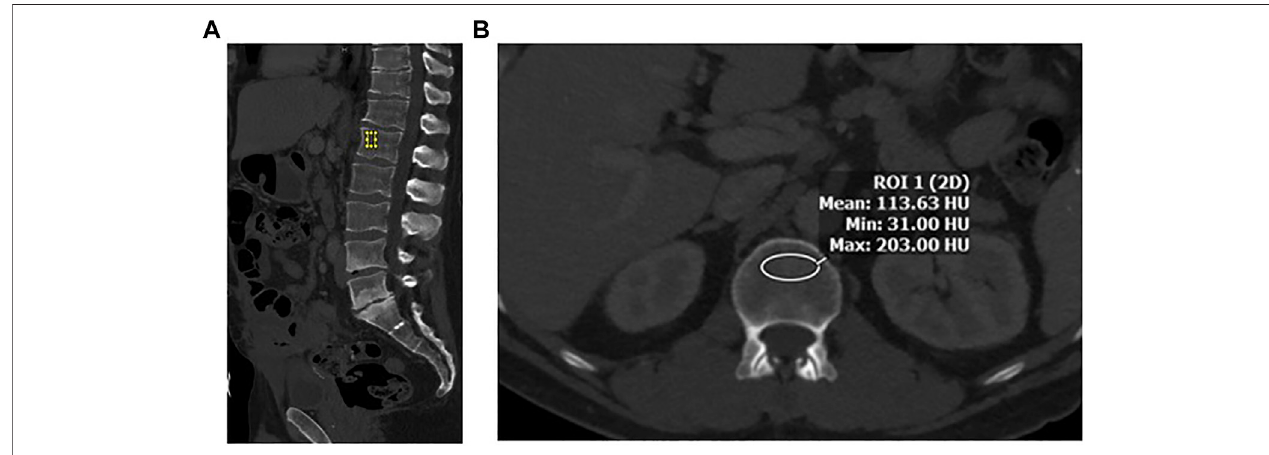
FIGURE 1 | (A) Sagittal image in bone windows demonstrating placementofan elliptical region of interestat L1 along the anterior aspect of the vertebral body. (B) Axial image at the L1 level along the superior aspect, with an elliptical region of interest to measure CT-derived bone density in Houns fi eld Units (HU).